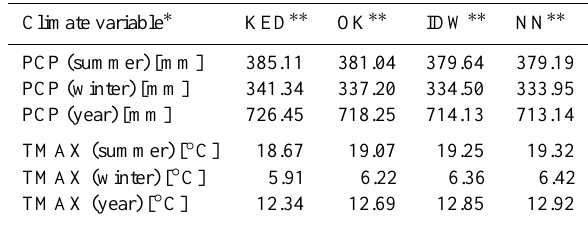
Table 2. Exemplary results of the spatial interpolation of the climate